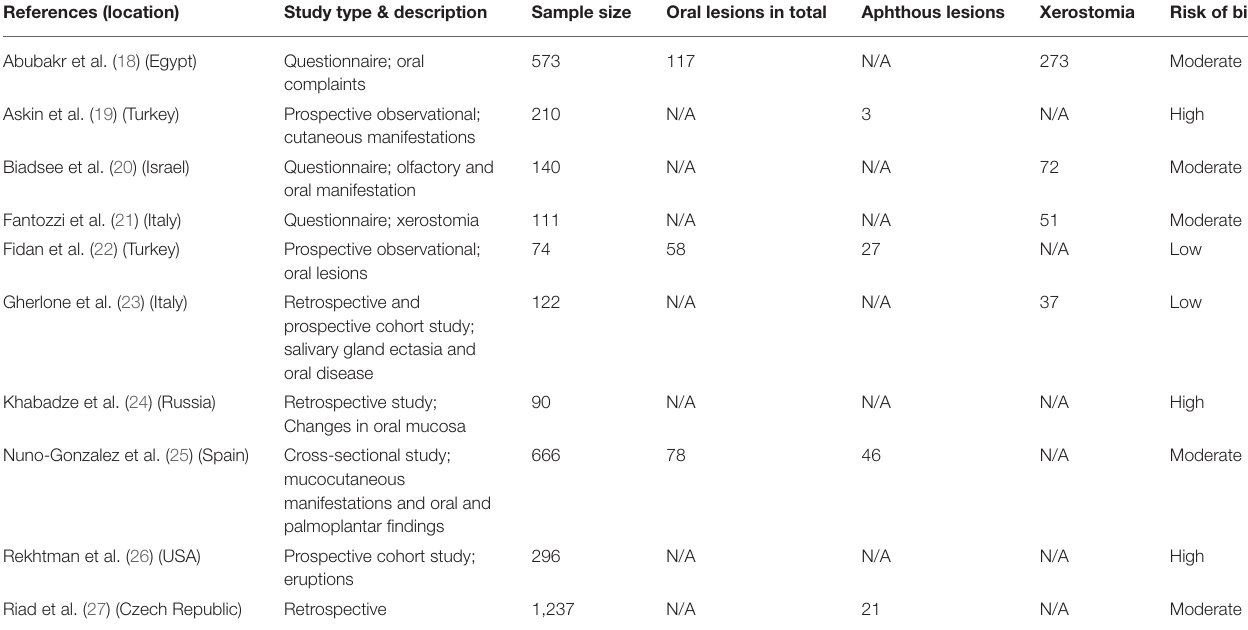
TABLE 1 | Characteristics of prevalence studies.